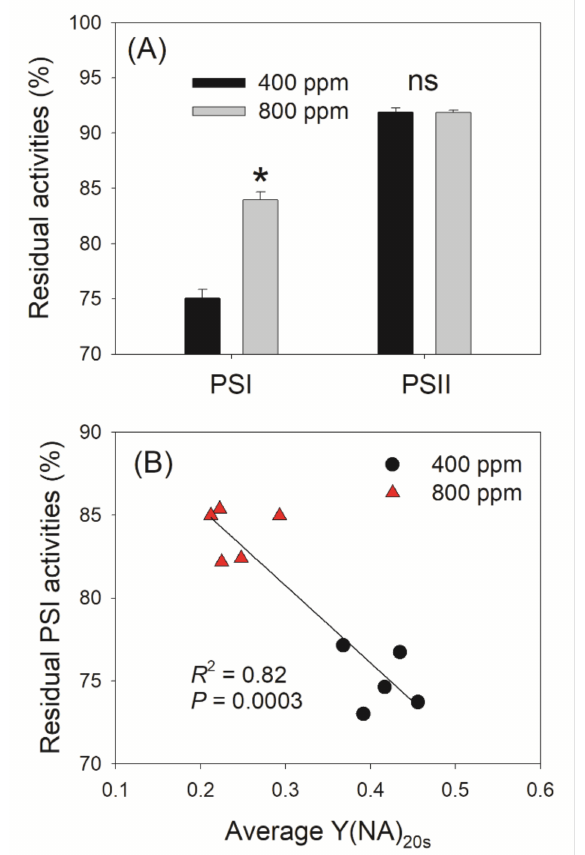
Figure 7. Effect of elevated CO 2 concentration of photoinhibition under fluctuating light and its relationship to redox state of PSI. ( A ) Changes in P m and F v /F m after exposure to fluctuating light for 24 min. F v /F m and P m represent photosystem PSII and PSI activity, respectively; ( B ) Relationship between residual PSI activity and the mean value of Y(NA) after transition to high light for 20 s (Y(NA) 20s ). Data are shown as means ± SD (n = 5). Asterisk indicates a significant different between 400 and 800